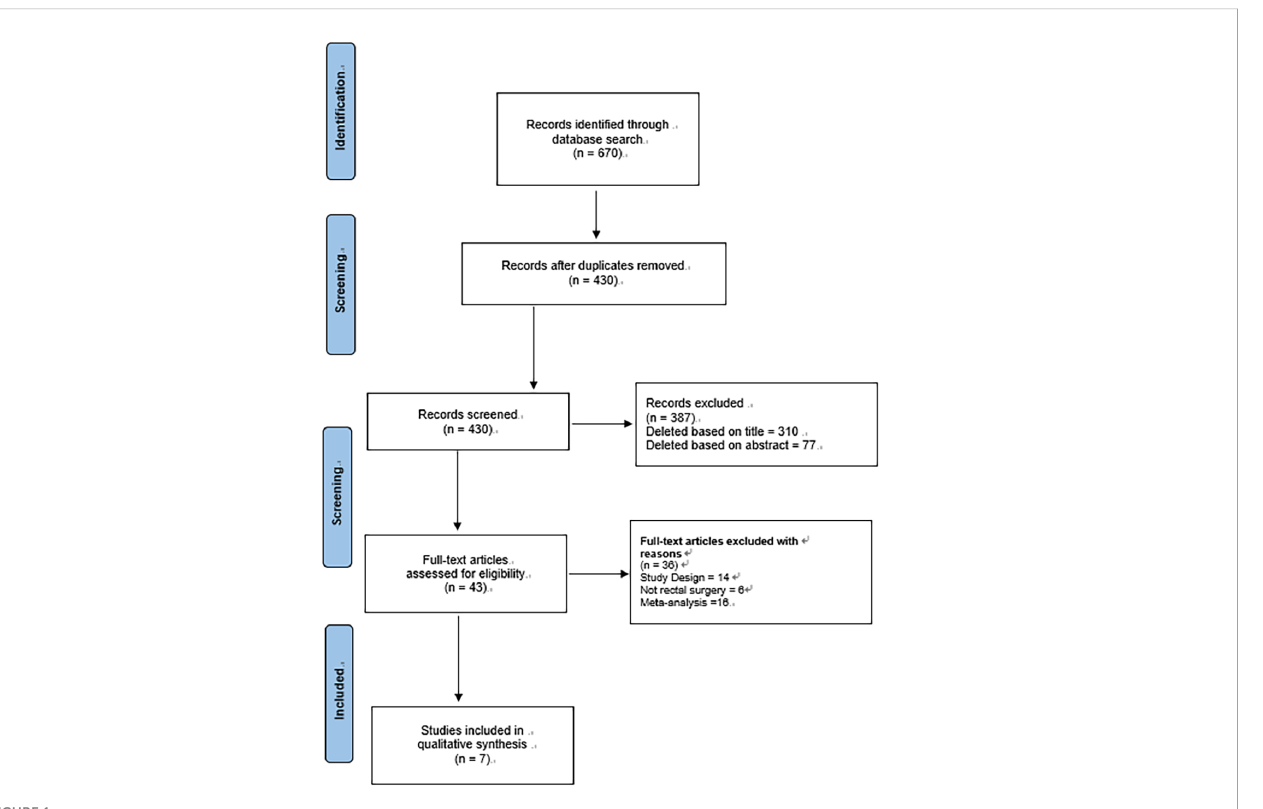
FIGURE 1 Flowchart of the screening process for included